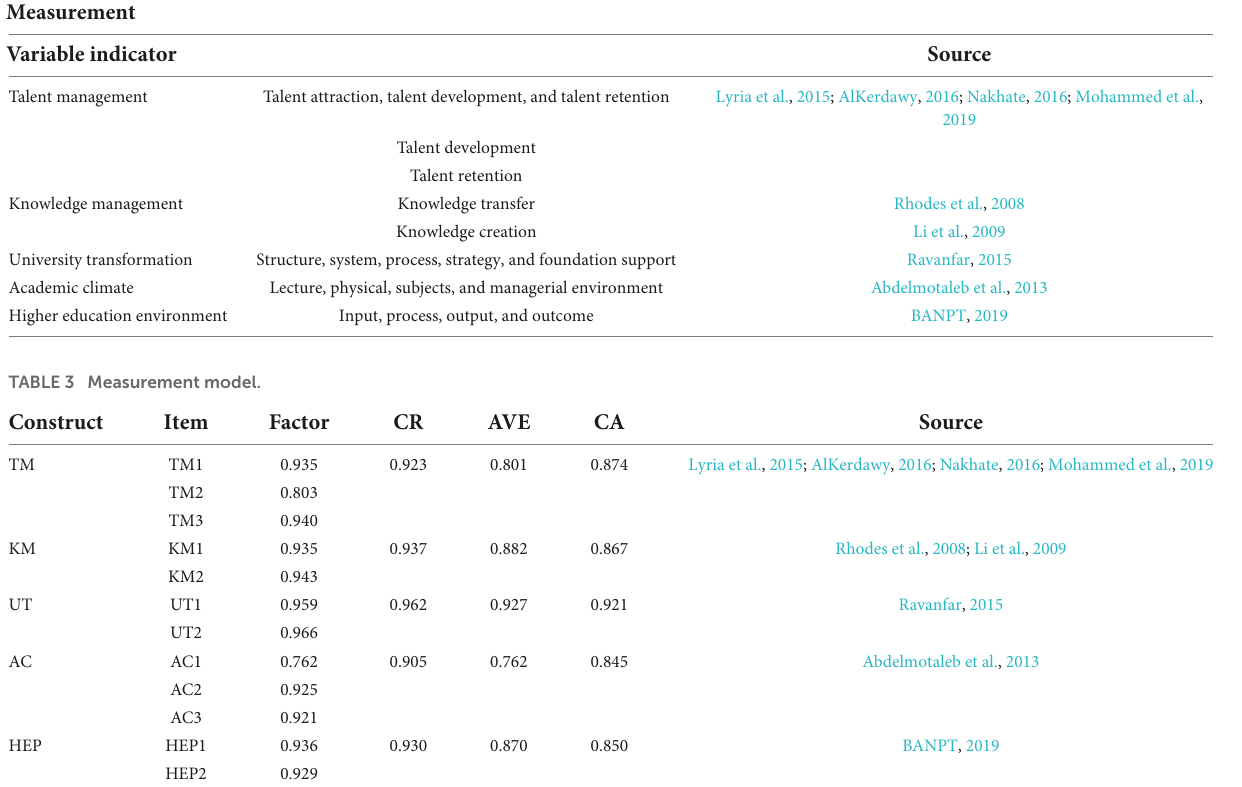
TABLE 2 Measurement variables.